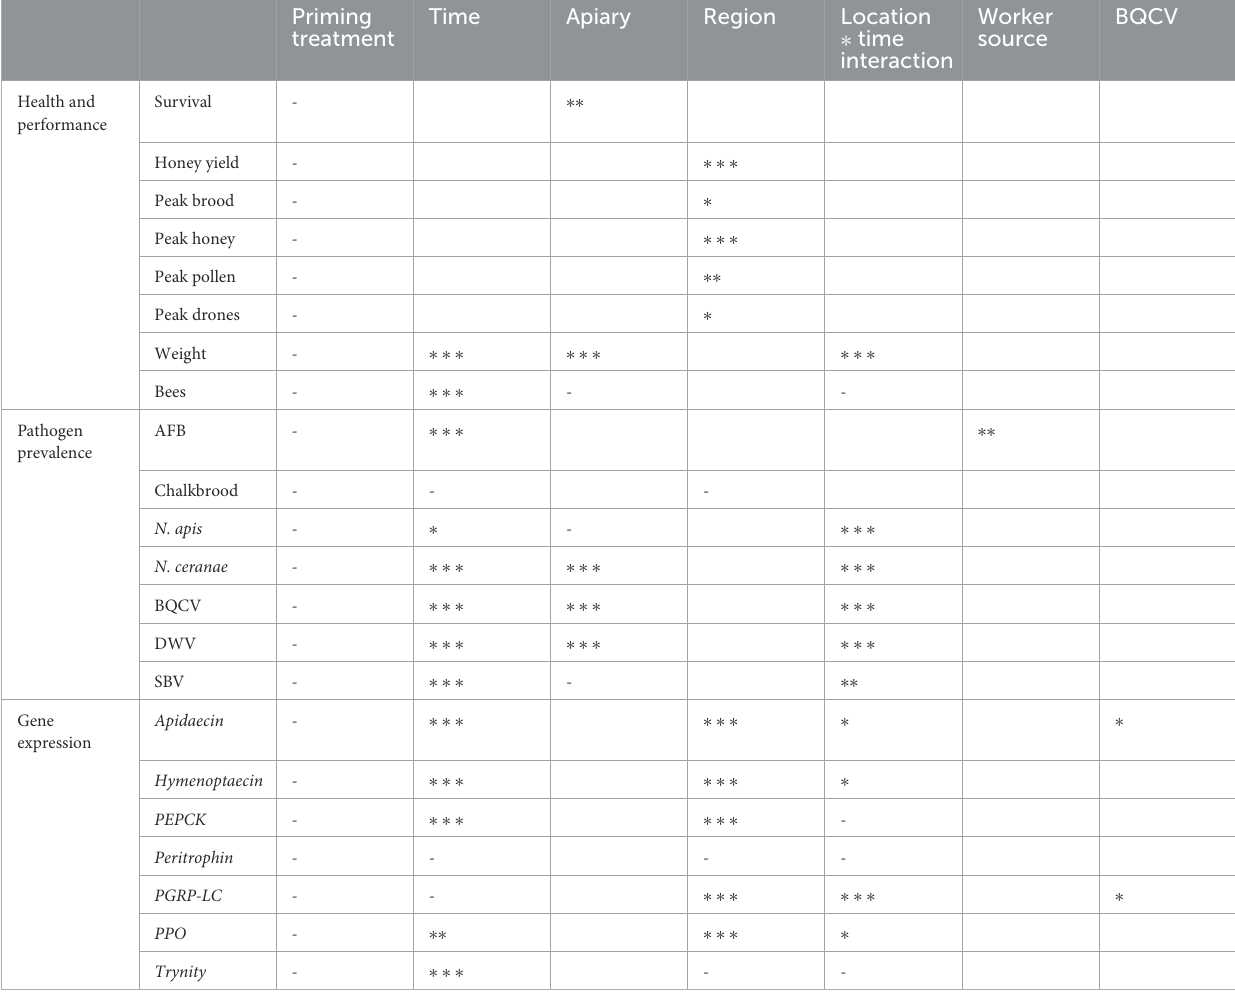
TABLE 2 Summary table of significant effects in the models reported in this study, as indicated by Type II/III analysis of variance tables (Satterthwaite’s method). Priming